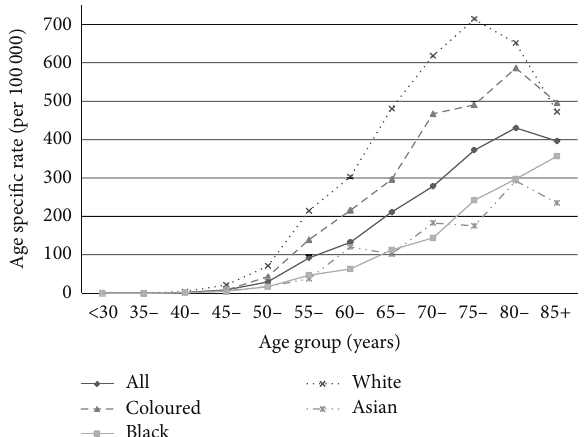
Figure 2: South African pathology based National Cancer Registry age specific incidence rate (ASIR) per 100 000 for prostate cancer, 2006, by population